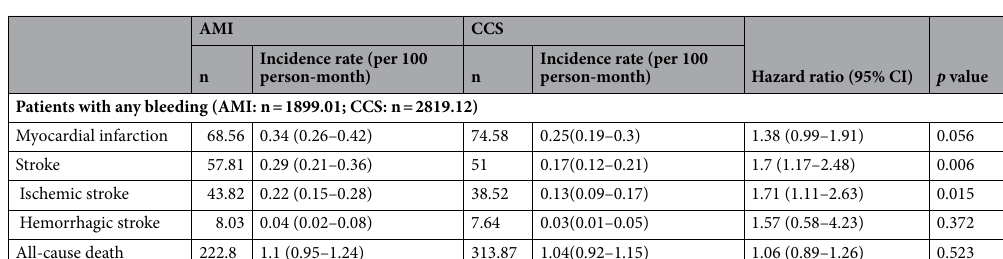
All-cause Table 3. Clinical outcomes at 1 year after bleeding in patients with AMI versus CCS (after propensity score weighting). AMI acute myocardial infarction, CCS chronic coronary syndrome, CI confidence interval.